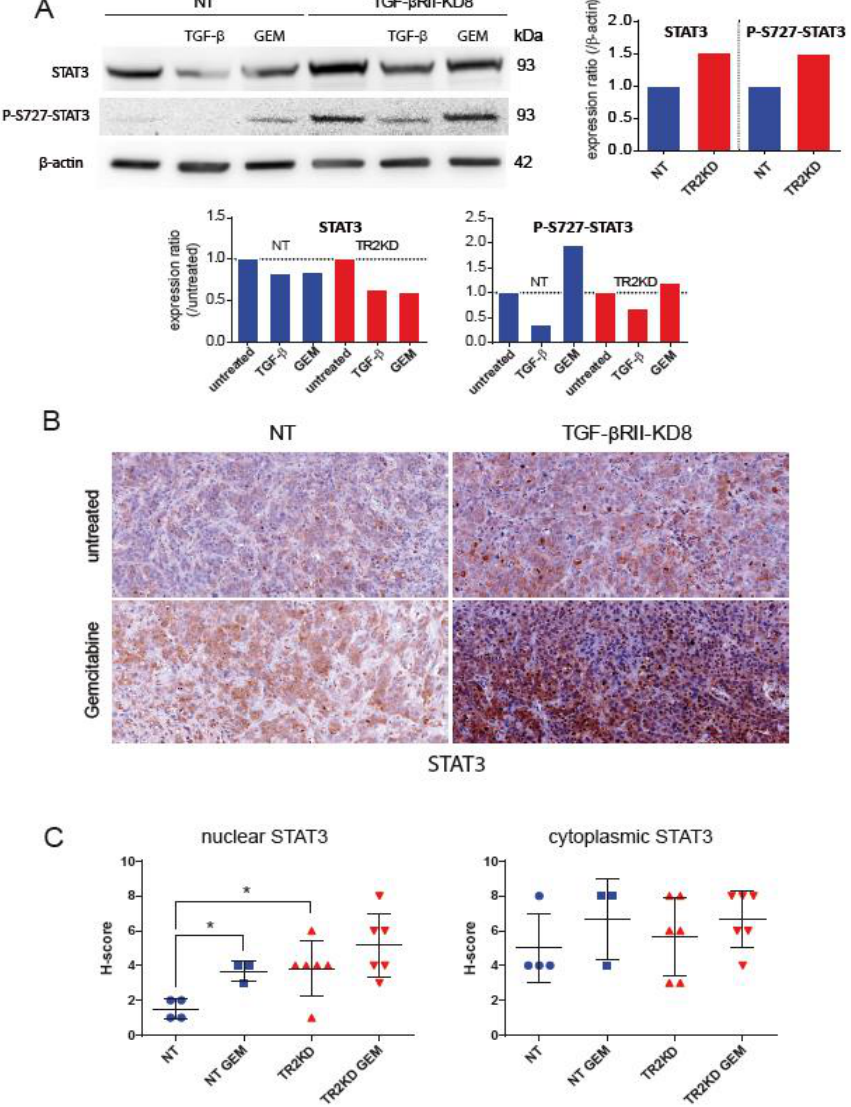
Figure 5. TGF- βRII knockdown promotes STAT3 phosphorylation and nuclear localization in Figure 5. TGF- β RII knockdown promotes STAT3 phosphorylation and nuclear localization in CAPAN-2 CAPAN-2 cells. ( A ) STAT3, phospho- S727 STAT3 and β -actin expression was analysed by western cells. ( A ) STAT3, phospho-S727 STAT3 and β -actin expression was analysed by western blotting. blotting. Bands intensities were quantified by densitometry and ratios (KD vs. NT or treated/untreated) are indicated in the graphs. Expression in NT (for TGF- βRIIKD) or untreated ( for